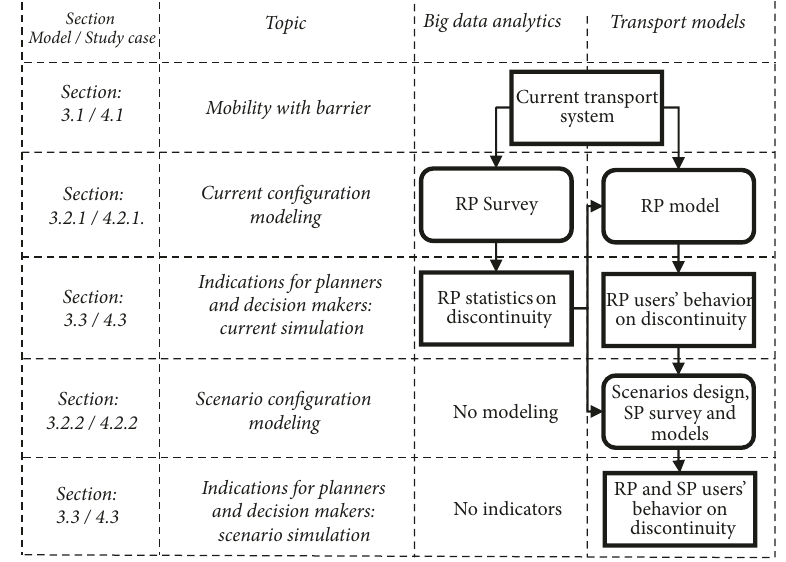
Figure 2: The proposed